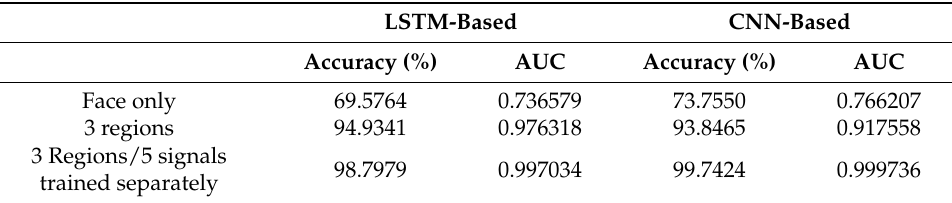
Table 2. Accuracy and AUC of the LSTM- and CNN-based